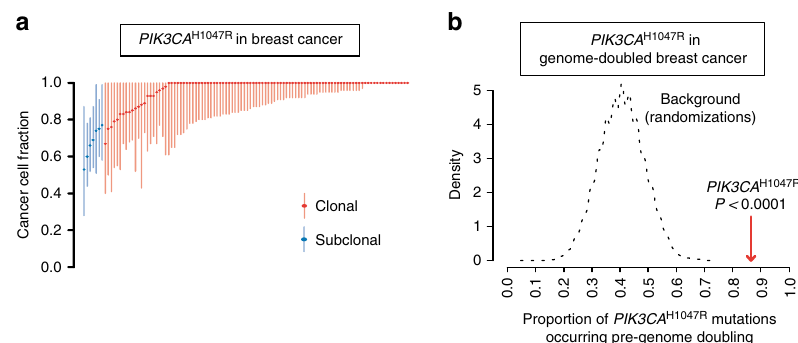
Fig. 7 The cancer cell fraction and timing of PIK3CA H1047R mutations in human breast cancer. a The cancer cell fraction of PIK3CA H1047R mutations in the TCGA breast cancer cohort. Each symbol represents a non-silent somatic mutation in an individual tumour. On the basis of the probability distributions of the cancer cell fraction, mutations were determined to be either clonal (red circles, upper bound of con fi dence interval ≥ 1) or subclonal (blue circles, upper band of con fi dence interval < 1). Error bars represent the 95% con fi dence interval. PIK3CA H1047R mutations are signi fi cantly more often clonal than subclonal ( P < 0.001). b Timing of PIK3CA H1047R mutations in the TCGA genome-doubled breast cancer cohort. The proportion of PIK3CA H1047R mutations that likely occurred prior to genome doubling is depicted with a dotted line representing expected distribution based on background randomizations. The graph shows that the majority of PIK3CA H1047R mutations likely precede genome doubling, more than expected by chance ( P < 0.0001). The proportion of pre-genome doubling is the proportion of PIK3CA H1047R mutations that occur pre-genome doubling. The distribution relates to the expected number of mutations occurring pre-genome doubling. This is based on taking the same number of mutations, and randomly sampling this 10,000 times. This gives an estimate of the likelihood that a random sample of mutations would show the same number of pre-doubled